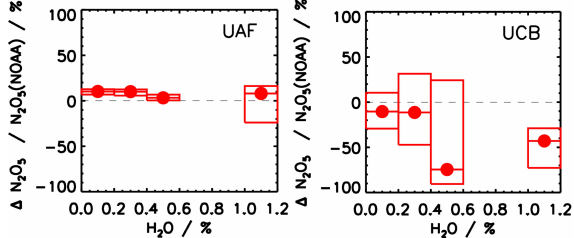
Fig. 4. Time series and correlation of N 2 O 5 measurements by UAF- CRDS and NOAA-CRDS on 16 and 17 June (limonene+NO 3 ). UAF-CRDS data are either plotted as reported or without a cor- rection factor, which was originally applied to account for an in- creasing N 2 O 5 loss on the filter over time (Table 1). The filter in the UAF-CRDS was exchanged in morning of both days before mea- surements started. Solid lines in the correlation plot show results from the regression analysis.